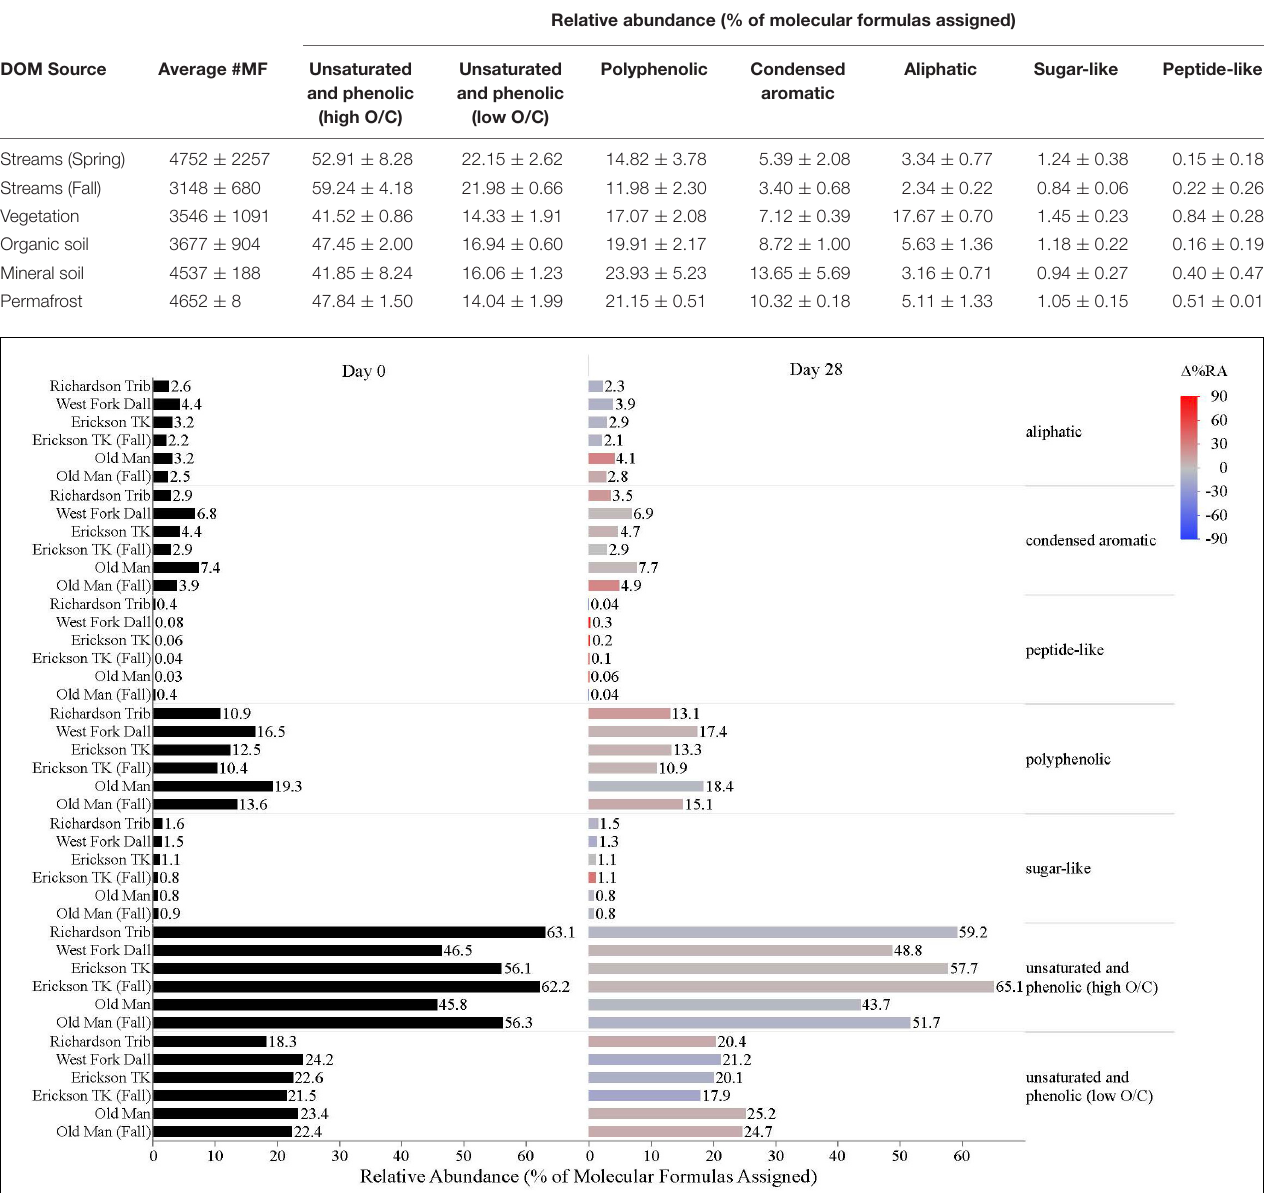
FIGURE 4 | Stream DOM composition by compound class and site. Bars indicate the relative abundance of different compound classes, with black bars showing the relative abundance at t = 0 and colored bars representing the relative abundance by t = 28. The color scale reflects the percent change in relative abundance of each DOM compound class over the bioincubations, with red bars indicating a relative increase in abundance and blue bars indicating a relative